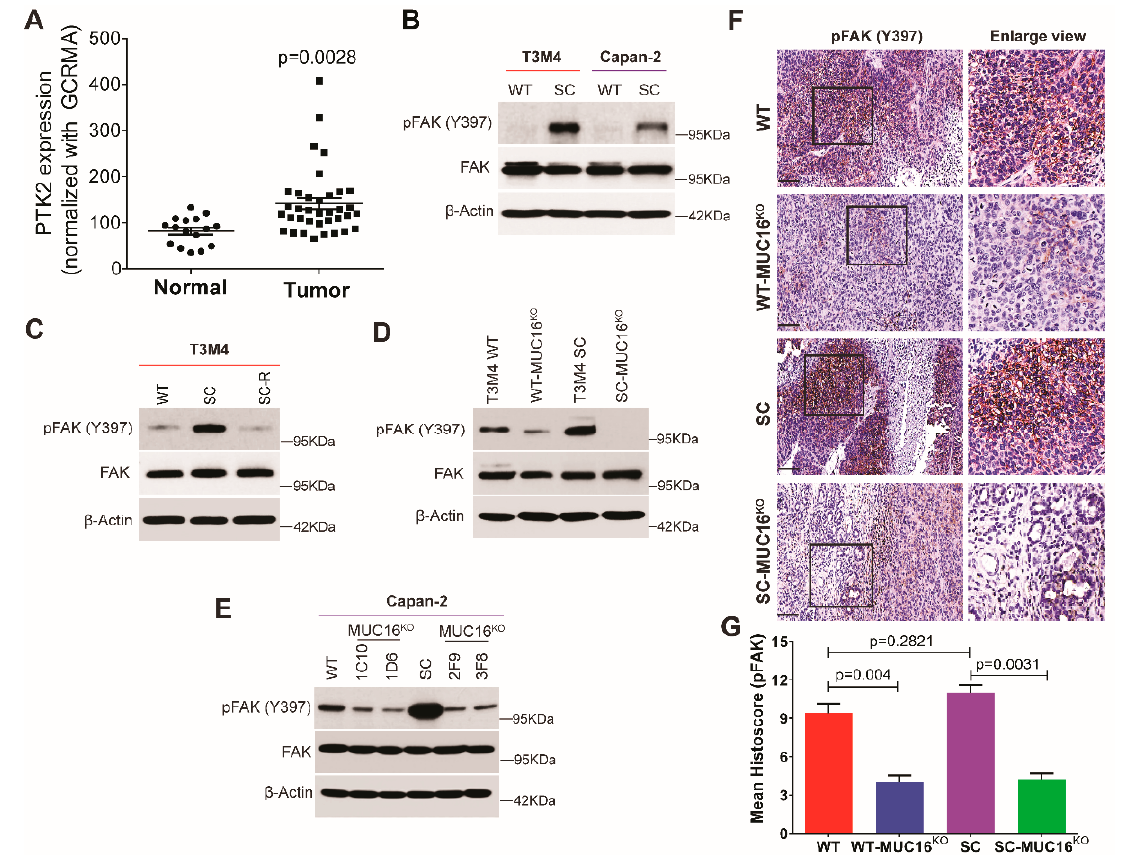
Figure 2. Aberrantly glycosylated MUC16 effectively mediates FAK signaling. ( A ) mRNA expression of the PTK2 gene (encoding FAK) was determined using microarray data from normal ( n = 16) and PDAC tumor ( n = 36) tissues; p value < 0.05 is considered statistically significant; Western blot analysis showing ( B ) phosphorylation of FAK at tyrosine 397 (pFAK Y397) and total FAK expression in T3M4 and Capan-2 WT and SC cells; loading control: β -actin; ( C ) re-expression of COSMC in T3M4 SC-R rescues pFAK (Y397) level back to WT parental; loading control: β -actin; ( D ) genetic deletion of MUC16 causes a decrease in pFAK (FAK activation) in T3M4 WT and SC, and ( E ) Capan-2 WT and SC cells; loading control: β -actin; ( F ) immunohistochemistry staining using an antibody for pFAK (Y397) in tumor tissues derived from orthotopic implantation T3M4 WT, WT-MUC16 KO , SC, SC-MUC16 KO cells, as described previously [28]; ( G ) histoscore analysis of pFAK immunohistochemistry showing high pFAK in WT and SC cells and decrease with MUC16 KO in both cells. Data representation is as mean ± SEM analyzed using Dunnett’s multiple comparisons